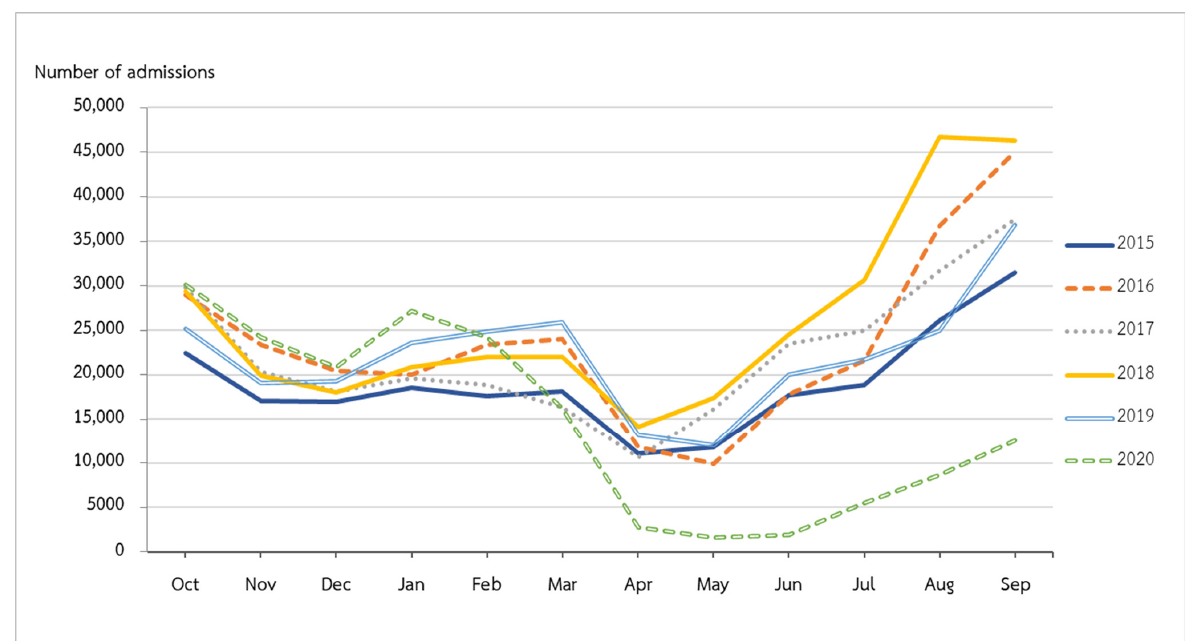
Figure 1. Number of hospitalized LRTIs in fiscal years 2015–2020.